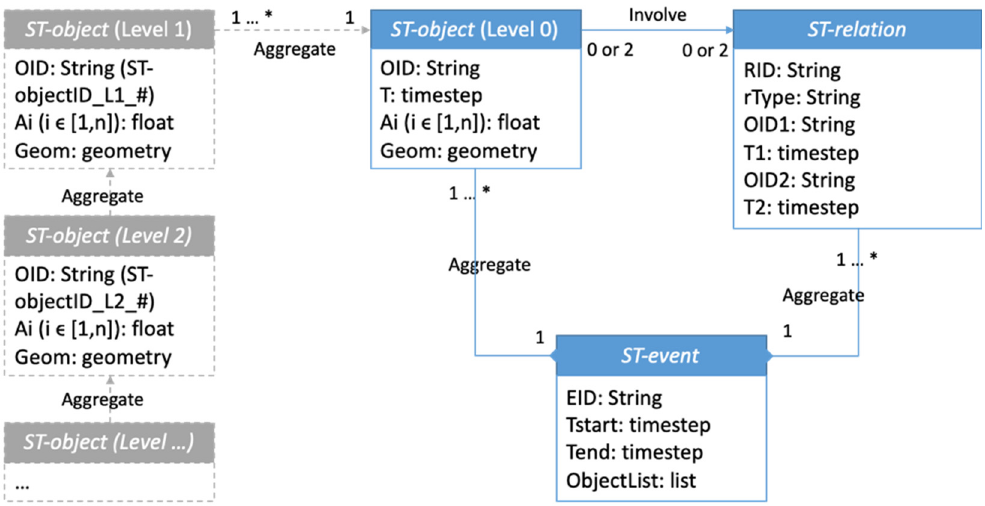
Figure 1. Overall conceptual data framework.